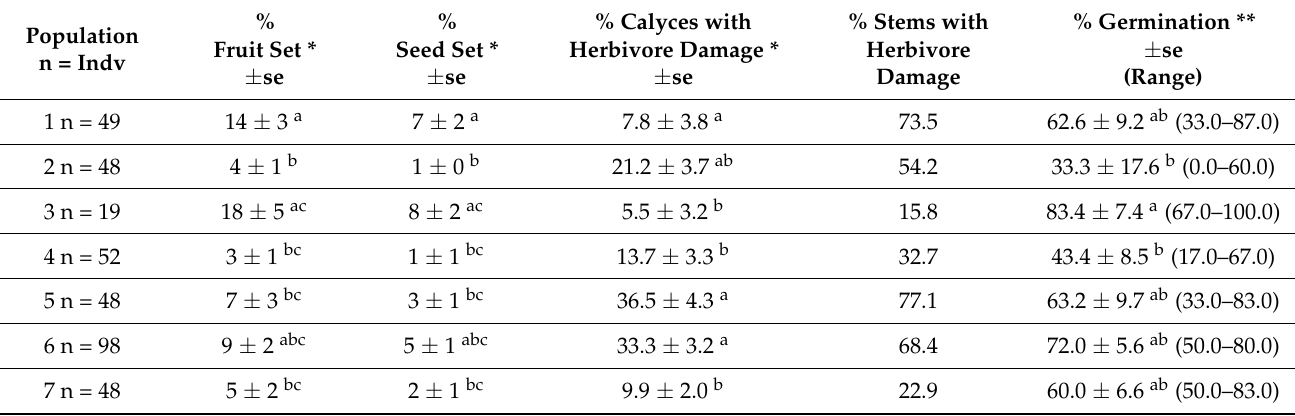
Table 2. Summary of the number of sampled individuals and the average fruit set and seed set (including developed seed and viviparous seed) per stem for each population. Percent calyces per stem and percent of stems per population with at least one incidence of herbivory. The average percent germination for each population as well the range of germination across replicates within a